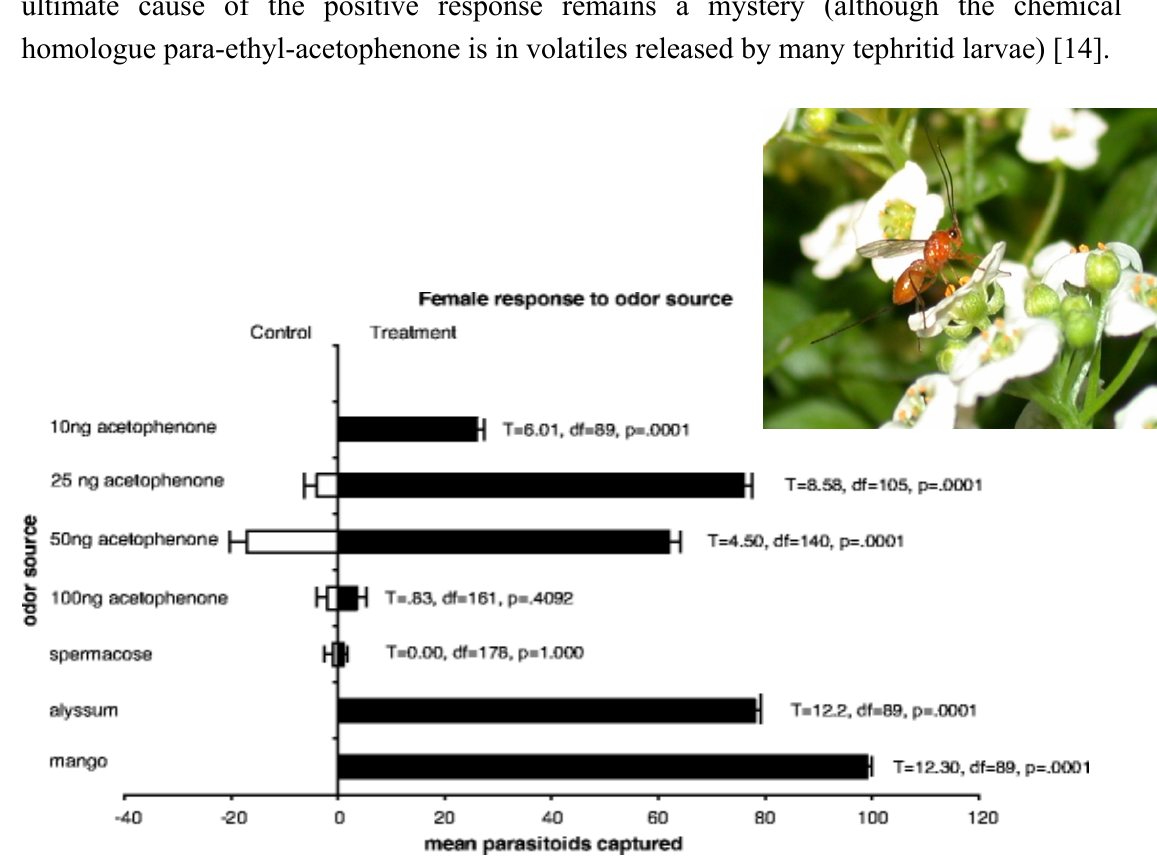
1. A synthetic attractant/trap to monitor the survival and dispersal